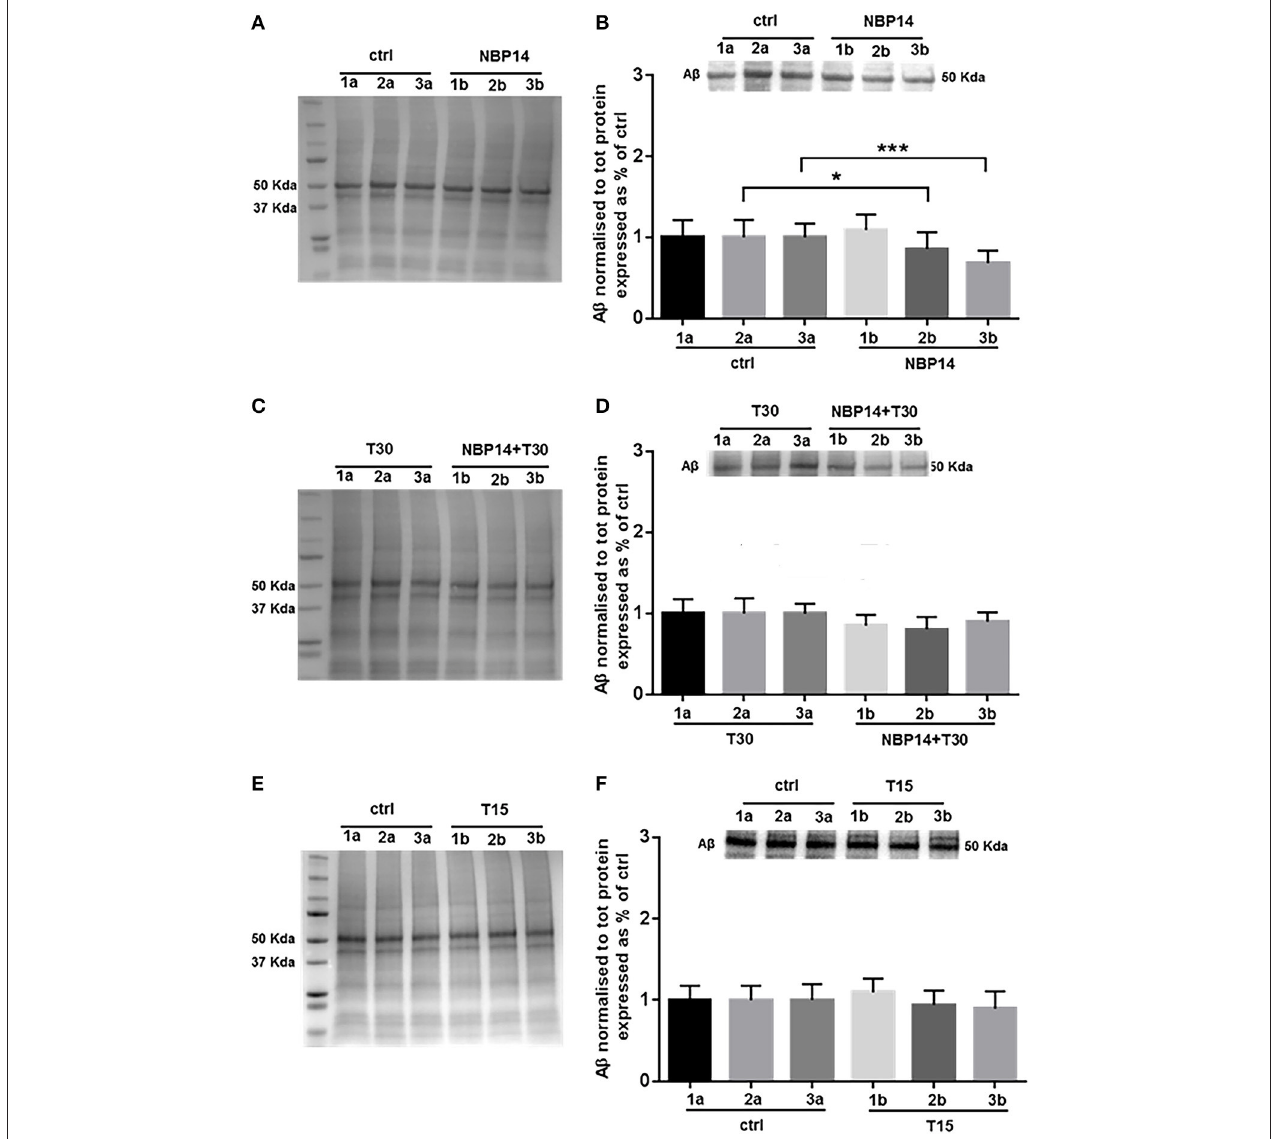
FIGURE 5 | Amyloid beta is specifically modulated by different treatments in the basal forebrain. (A,C,E) Representative total protein staining used as loading control. (B,D,F) Representative immunoblots and bar graphs indicating A β levels along the three BF subdivisions. (A) Total protein membrane subsequently immunoblotted for A β . (B) Amyloid levels were strongly affected between conditions and BF axis [ F (5,55) = 7.384, p < 0.0001, two-way ANOVA]. A similar expression was detected in the rostral portion (1a and 1b), while the intermediate (2b) and caudal (3b) exposed regions revealed a significant reduction over their untreated sides (2a and 3a) (slice 1, p = 0.3756, t = 0.9234; slice 2, p = 0.0186, t = 2.758; slice 3, p = 0.0007, t = 4.664, two tailed paired t -test). (C) Total protein membrane subsequently immunoblotted for A β . (D) The comparison between conditions and anatomical planes did not show a significant interaction [ F (5, 35) = 1.503, p = 0.2139,